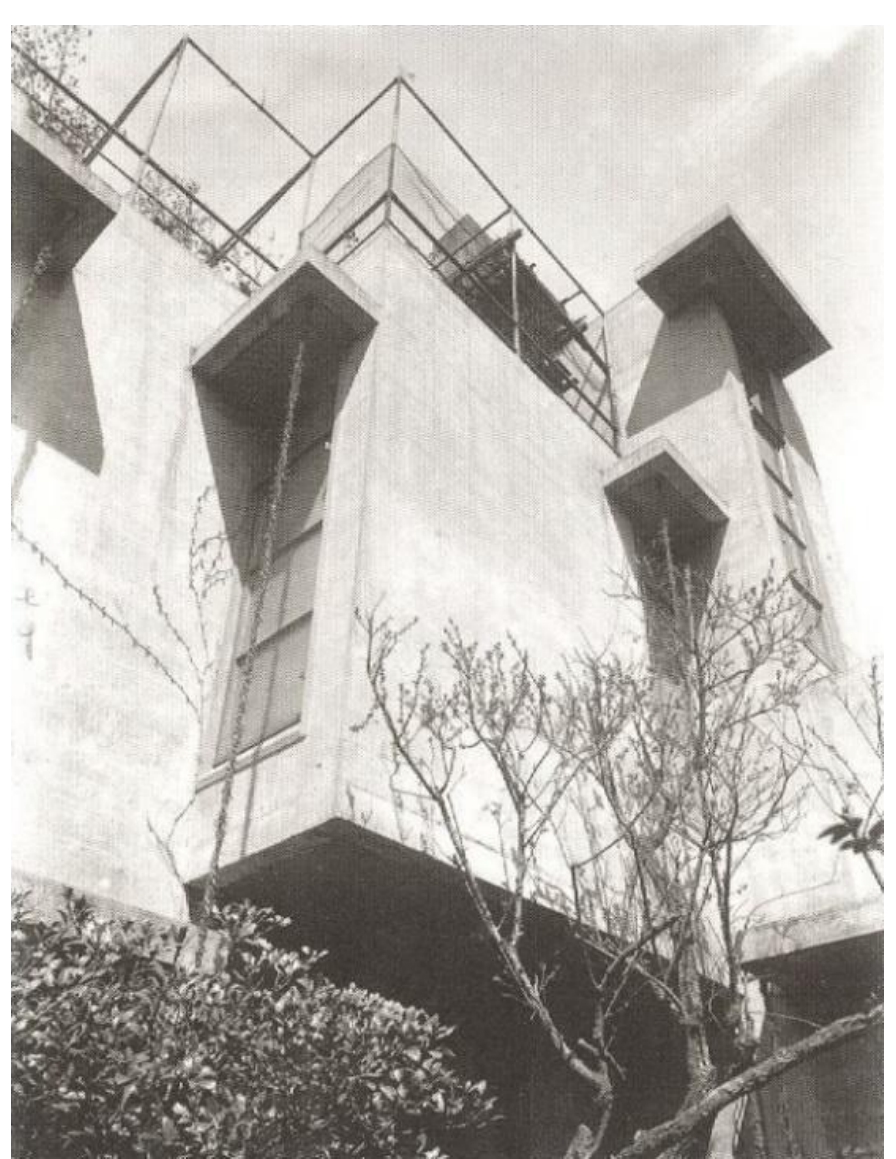
Figure 7. Reinanzaka house of the Raymond family 1924—detail of the concrete eyebrows and of the ropes for evacuating the rainwater, looking up from the